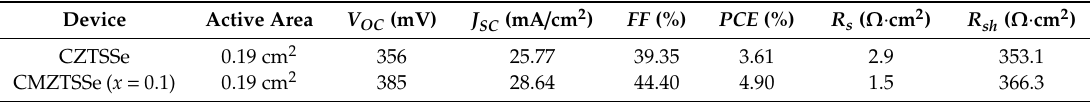
Table 3. Parameters of the device performance.